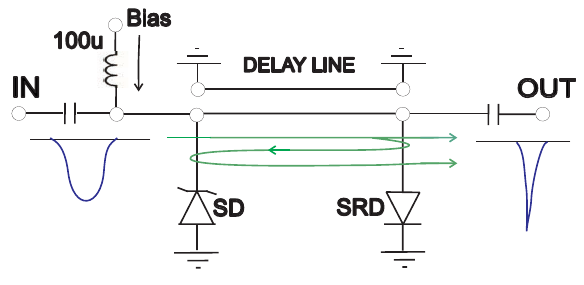
Figure 5: operating mode of SRD pulse sharping circuit.